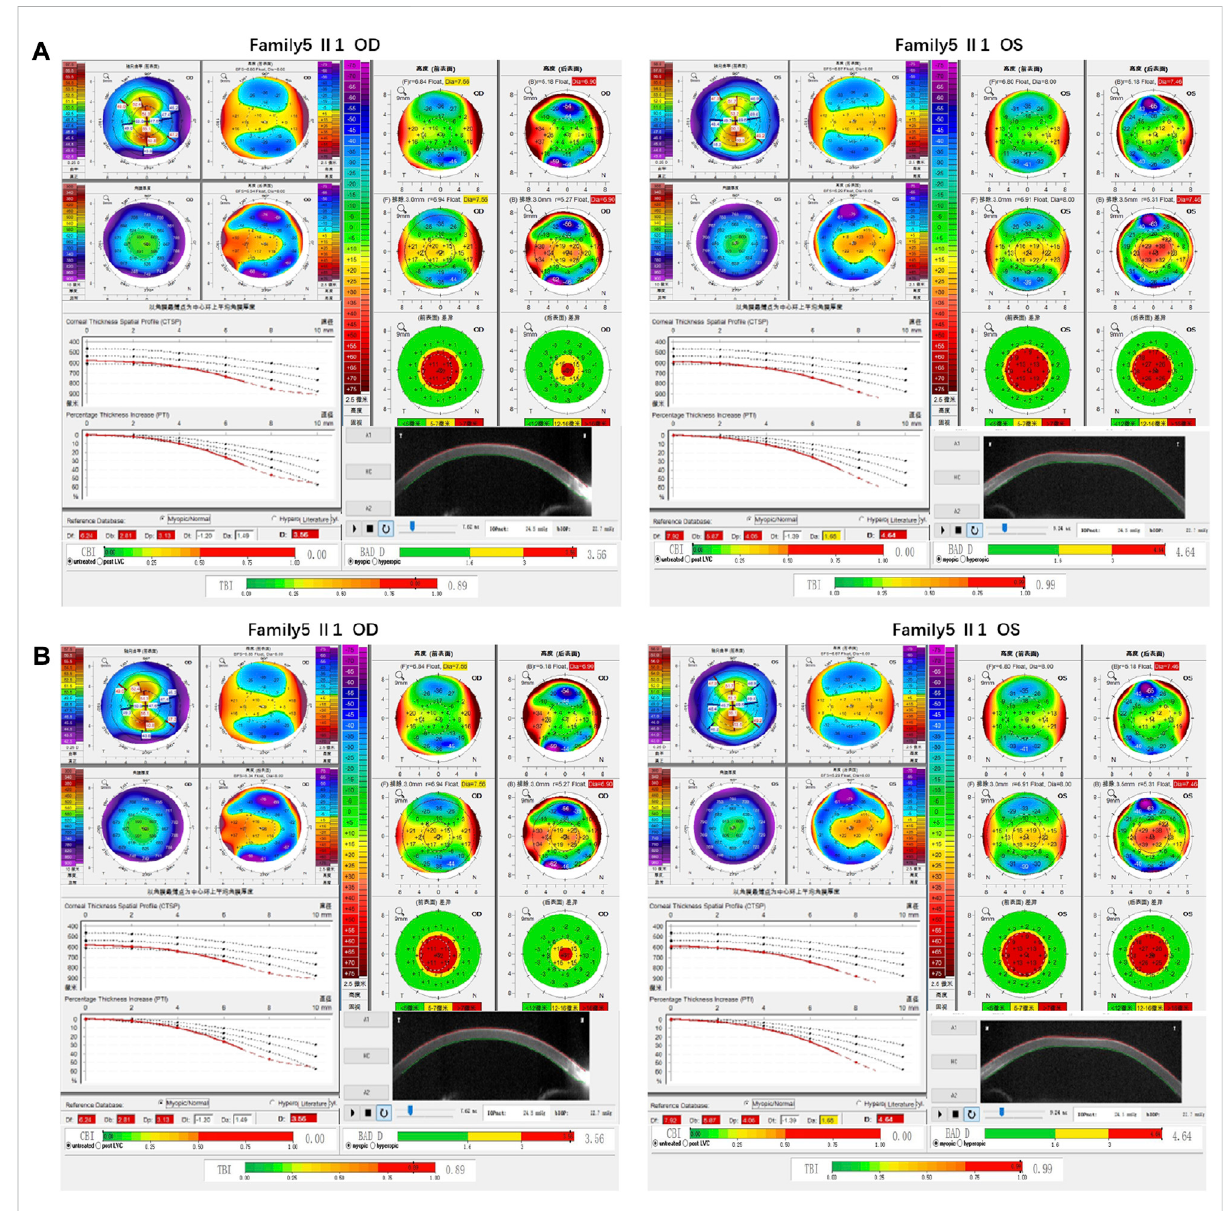
FIGURE 9 Corneal topographic map and corneal biomechanical examination in family5. (A) Kmax, Ef, Df, Db, Dp, D, BAD-D, TBI showing pathological values (red) in the proband. (B) BAD-D showing suspicious values (yellow) and Kmax, TBI showing pathological values (red) in the proband ’ s